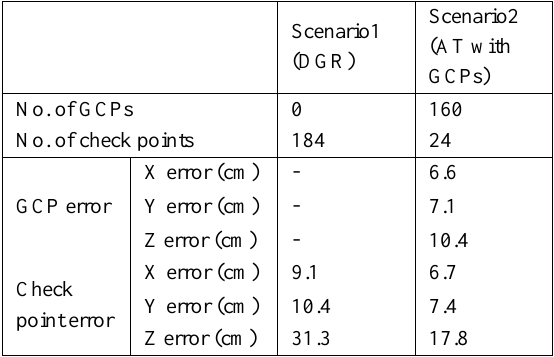
Table 3. The results of aerial triangulation for the project area in DGR and using GCP scenarios